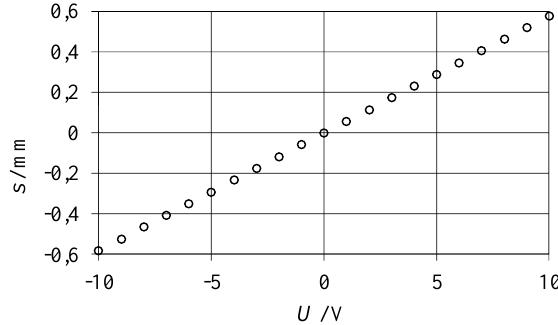
Fig. 3. Dependence of spool stroke s on input voltage U